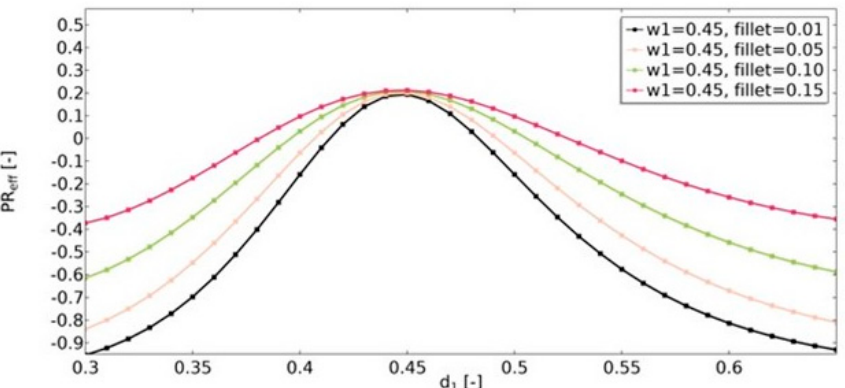
Figure 18. The influence of fillet radius on the value of effective Poisson’s ratio for w 1 = 0.45.